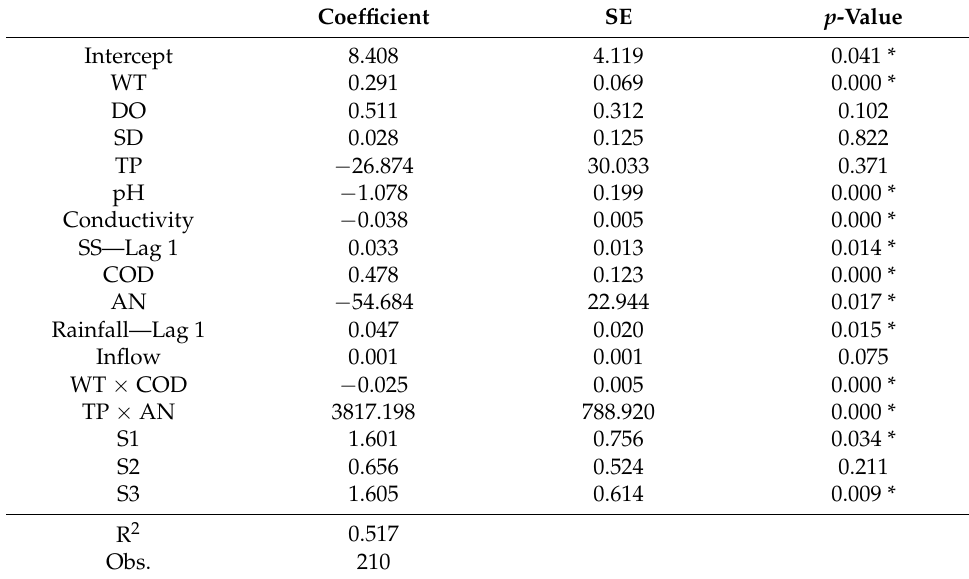
Table 5. Results from regression analyses of the Shimen Reservoir data.